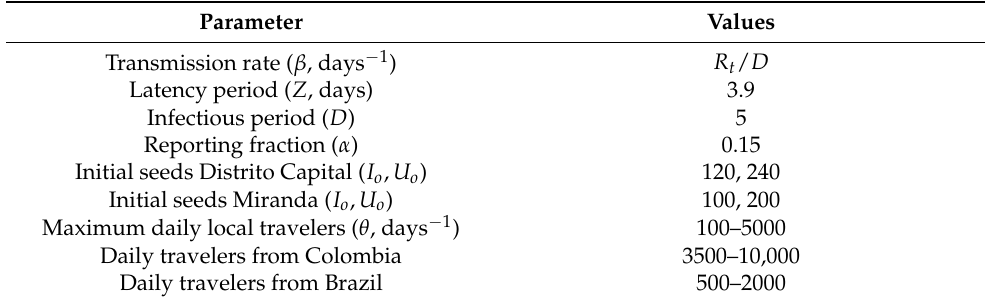
Table 1. Epidemiological parameters, initial conditions and range of daily movements used for simulations within the metapopulation SEI